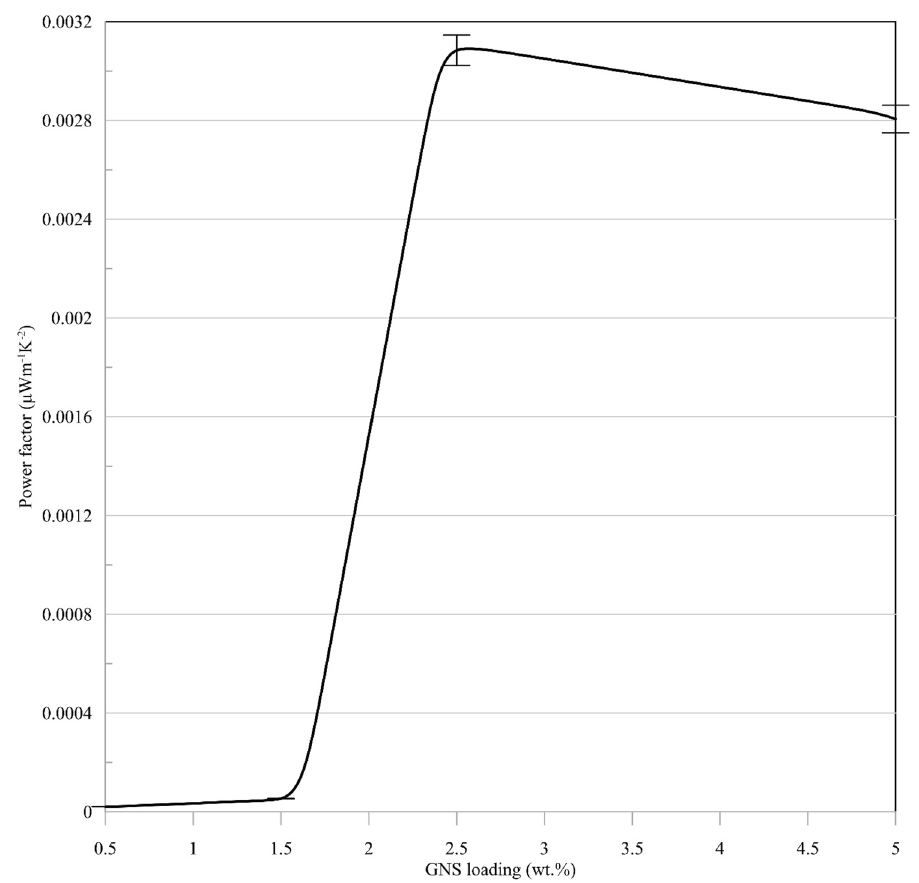
Fig. 8 Power factor as a func- tion of wt% GNS measured at average temperature (338